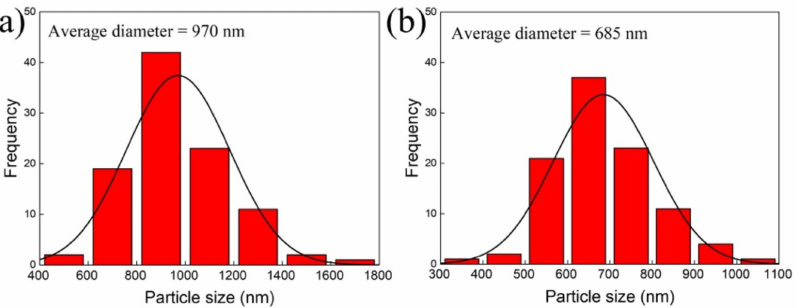
Figure 4. Size distribution of ( a ) spherical PVP/Al 2 O 3 /Fe 2 O 3 particles and ( b ) hollow Fe 3 O 4 nanospheres. The distribution used to measure the particle size corresponded to a normal